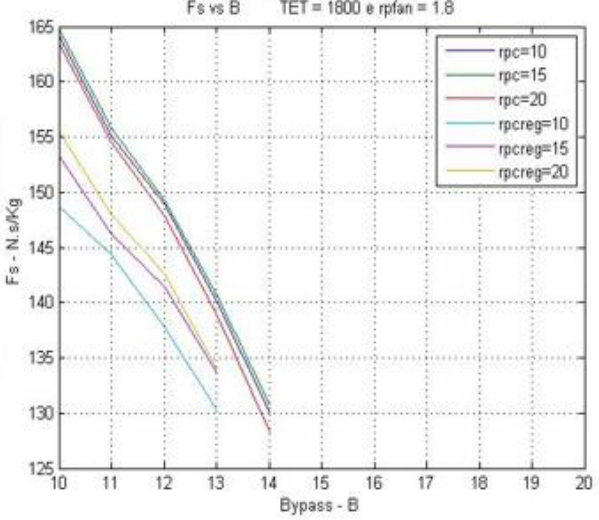
Figure 4: Fs vs BPR with and without regeneration (TET 1800 K and rpfan 1.8).